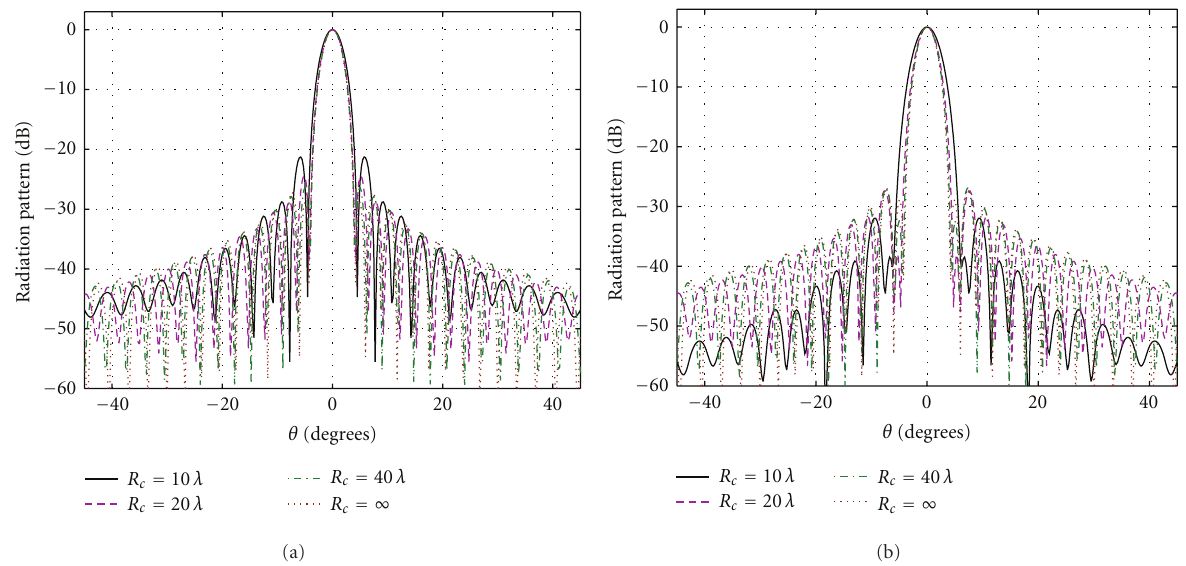
Figure 3: Radiation patterns of cylindrical reflectarrays: (a) concave, (b) convex.